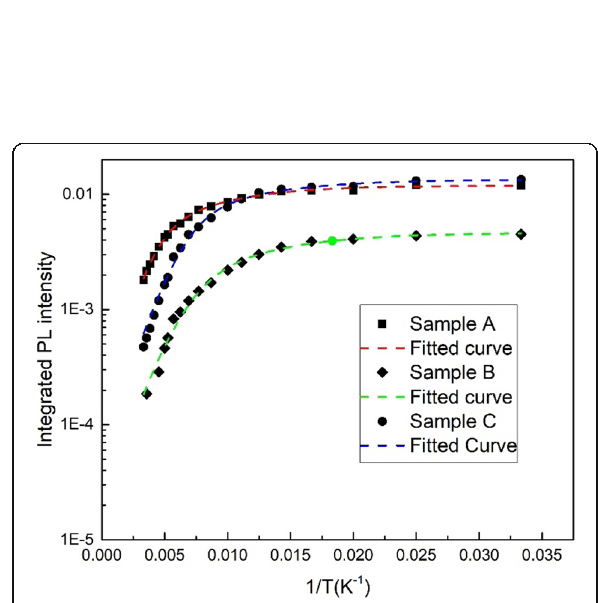
Fig. 6 Integrated PL intensity as a function of reverse temperature for samples A, B, and